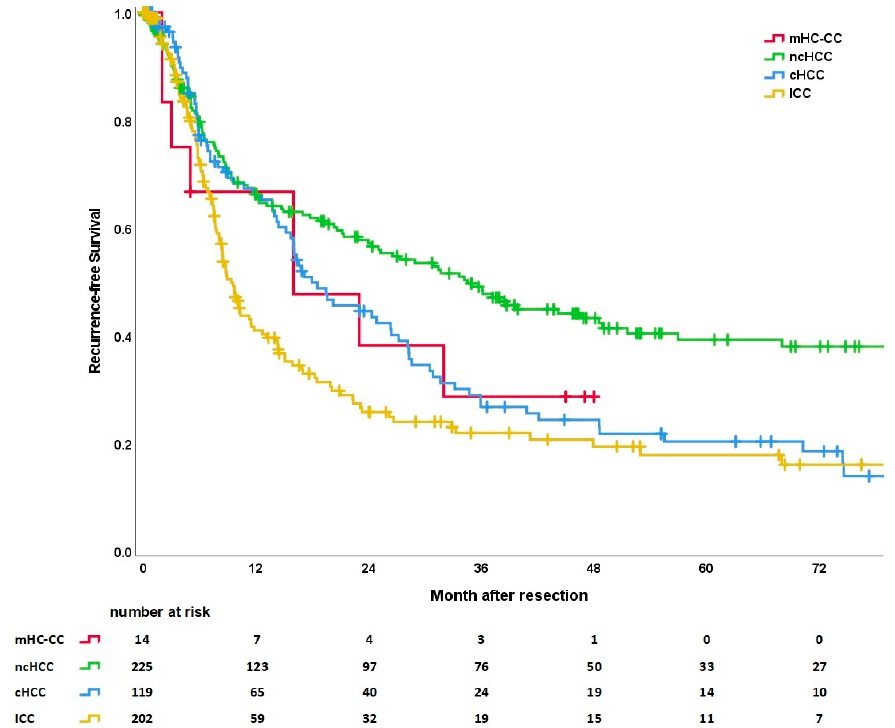
Figure 4. Recurrence-free survival curves according to tumor entity ( p < 0.001). Subgroups mHC- CC vs. ncHCC ( p = 0.244), mHC-CC vs. cHCC ( p = 0.926), mHC-CC vs. ICC ( p = 0.479), ncHCC vs. cHCC ( p = 0.003), ncHCC vs. ICC ( p < 0.001), and cHCC vs. ICC ( p = 0.040). Six patients with OLT for mHC-CC were excluded.